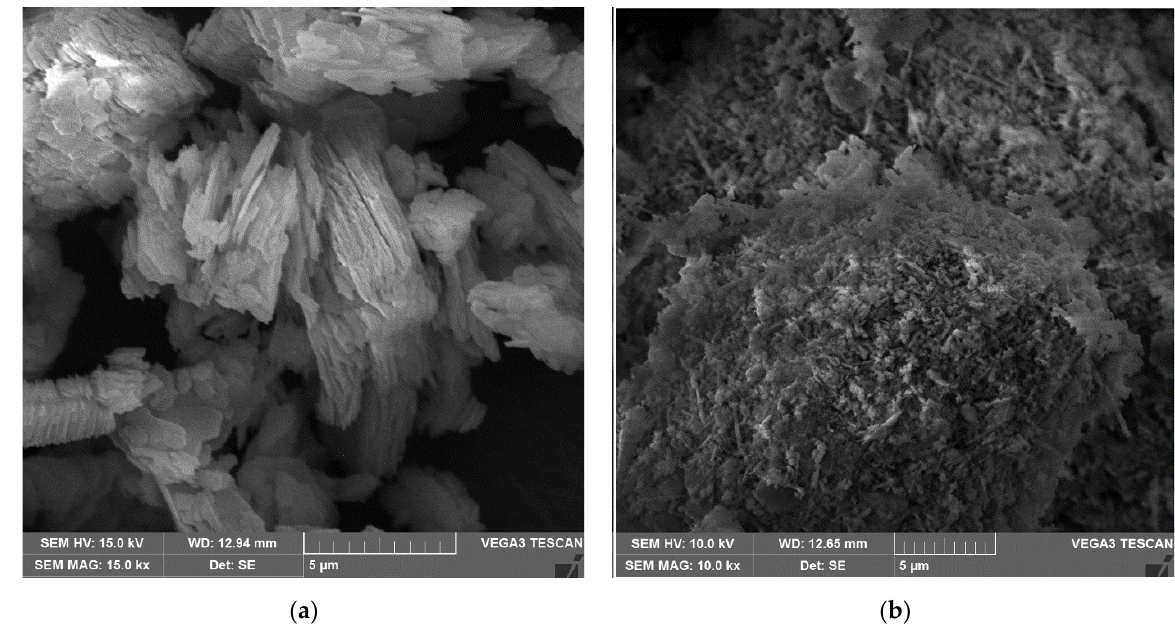
Figure 2. SEM image on: ( a ) MK1; ( b ) MK2 [×15,000]. Particle size distribution was assessed using the 3500 Particle Size Analyzer (Micro- trac, York, PA, USA), with a detection range of 0.1–3500 µm. The particle size distribution (PSD) of both materials is represented in Figure 3, and the specifications of D(10), D(50), and D(90) are indicated in the inserted table. Overall, MK2 has larger particles than MK1, with an average diameter of 20 µm.